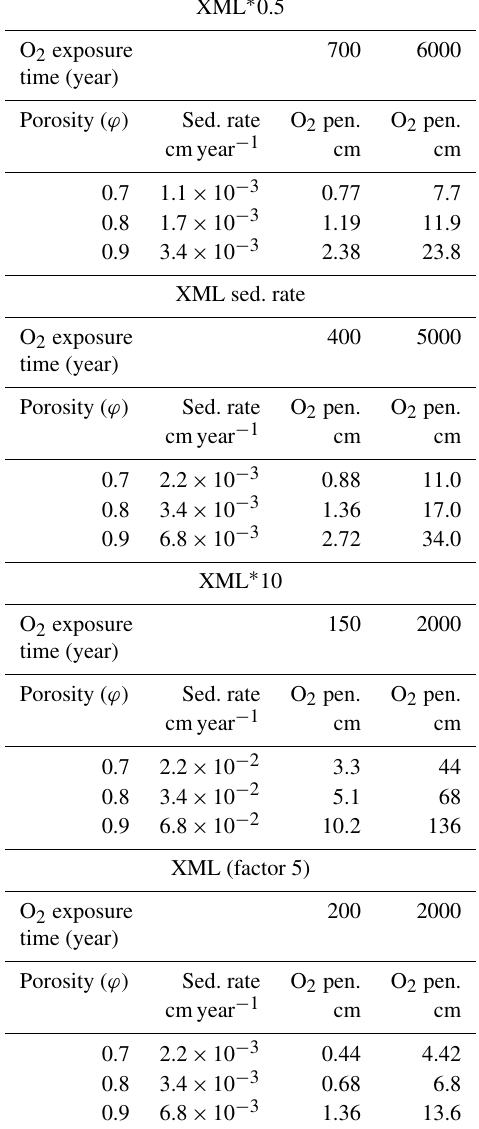
Table 3. Linear sedimentation rates and oxygen-penetration depths (O 2 pen.) for the different mass fluxes explored in our modeling. XML ∗